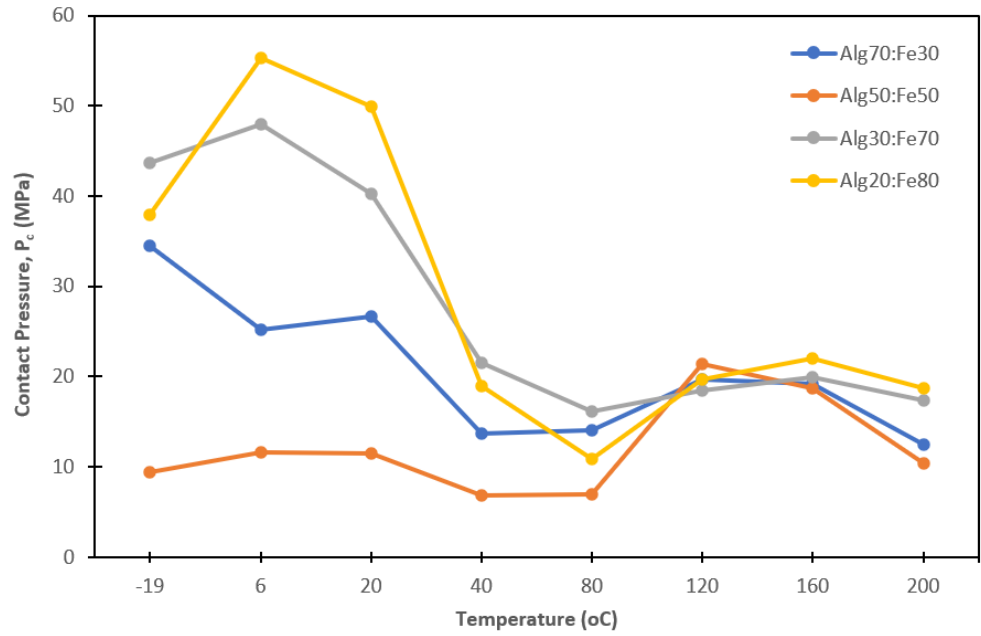
Figure 16. Thermal effect on the capsule Contact Pressure (P c ).